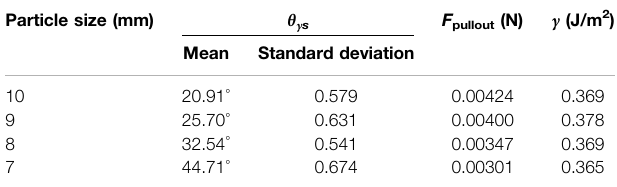
TABLE 4 | The static friction coef fi cient test results of B1 concrete. Particle size